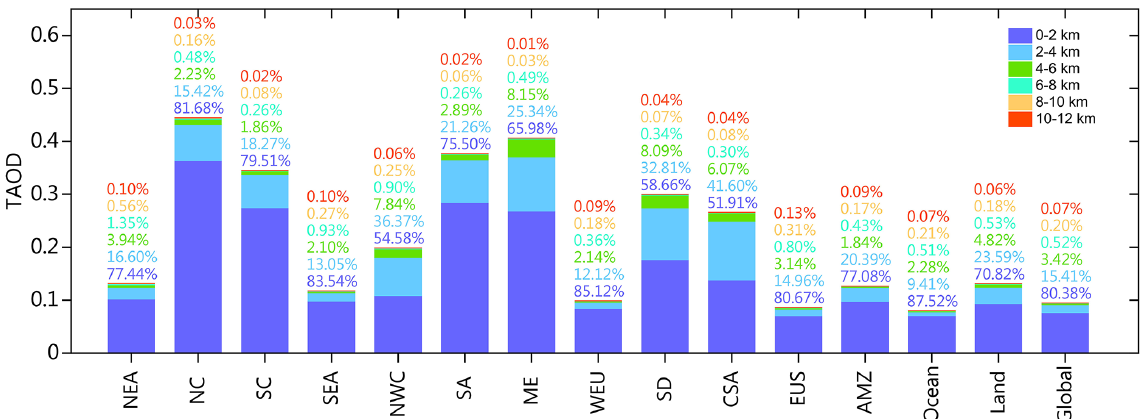
Figure 7. Multi-year regional-averaged layer-specific total AODs integrated at 2km intervals between 0 and 12km for the globe, land, ocean, and 12 ROIs. The colored numbers above each bar represent the relative proportions (%) of the layer-specific AODs to the total AODs.